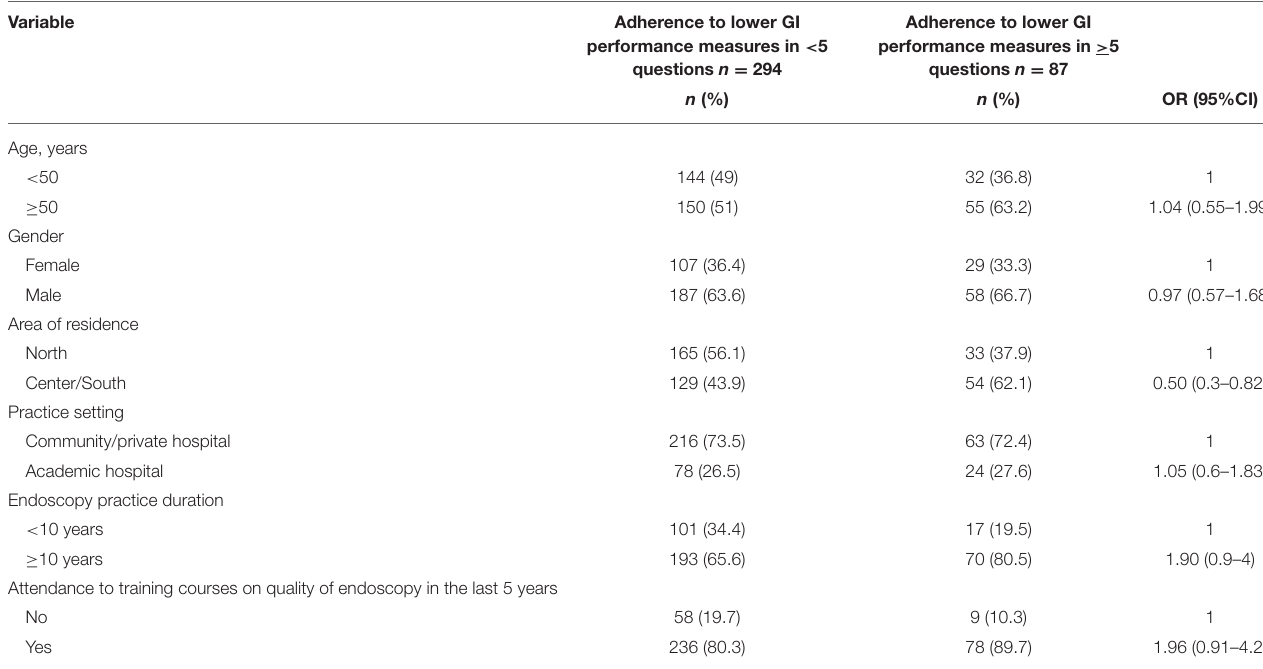
TABLE 5 | Predictors of adherence to performance measures for lower gastrointestinal endoscopy in at least 5 out of 6 questions (respondents n = 381).